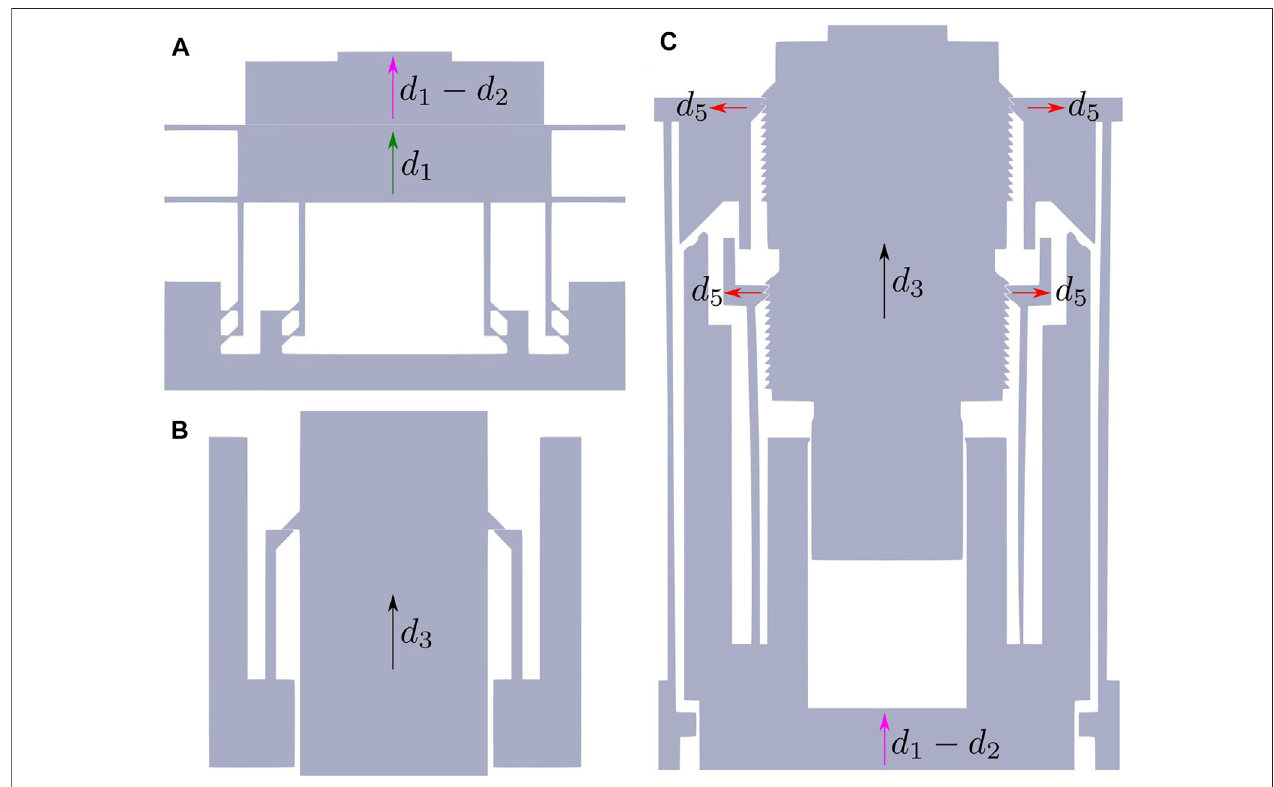
FIGURE 4 | Con fi gurations after arming for the (A) bottom stop-block, (B) top stop-block, (C) and gripping